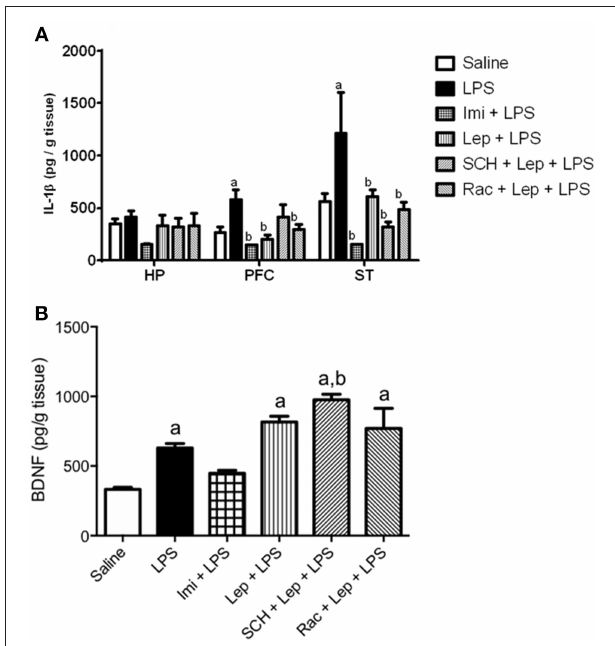
FIGURE 5 | (A) Levels of IL-1 β in the prefrontal cortex, hippocampus and striatum and (B) BDNF levels in the hippocampus of animals of animals submitted to protocol 2. Bars represent mean ± standard error of the mean (S.E.M.) of 6–7 animals/group. a P < 0.05 vs. control, b P < 0.05 vs. LPS according to one-way ANOVA followed by Tukey’s multiple comparison test. SCH, SCH23390; Rac, raclopride; Lep, leptin; Imi, imipramine; LPS, Lipopolysaccharide; HP, hippocampus; PFC, prefrontal cortex; ST, striatum; IL-1 β , interleukin − 1 β ; BDNF, brain-derived neurotrophic